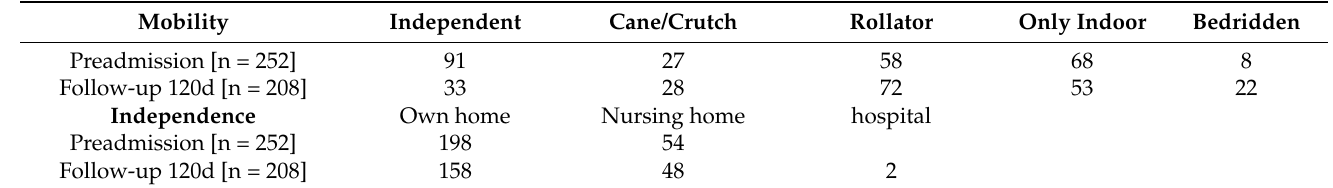
Table 2. Details of the two outcome parameters: mobility and independence.